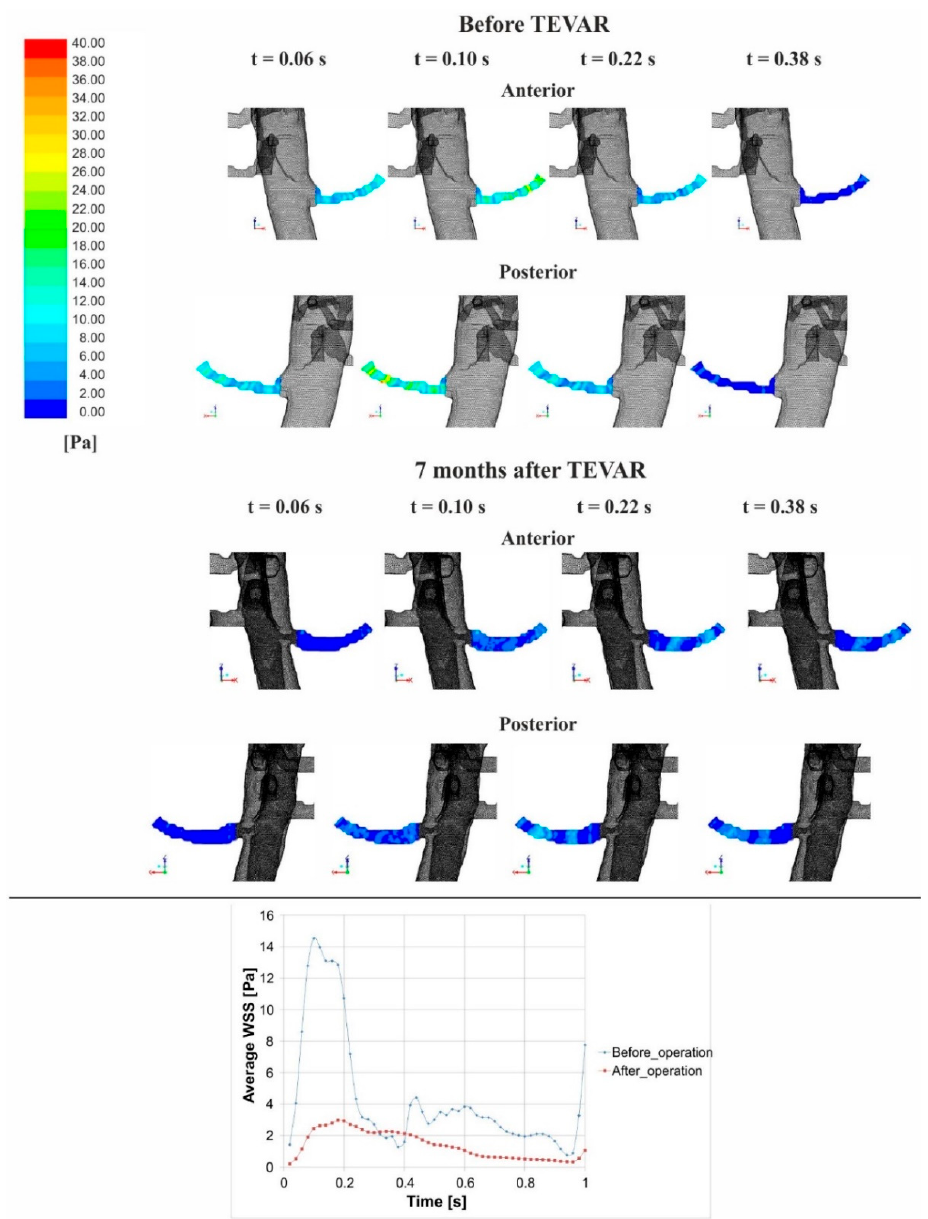
Figure 5. Changes in WSS contour distribution in the left renal artery for a representative patient. ( top ): WSS contour distribution in the left renal artery for representative time points before and 7 months after TEVAR; ( bottom ): the average velocity changes in the left renal artery for one cardiac cycle. Changes in WSS contours are presented for the anterior and posterior position in the left renal artery. Numerical simulations were calculated in ANSYS FLUENT software.